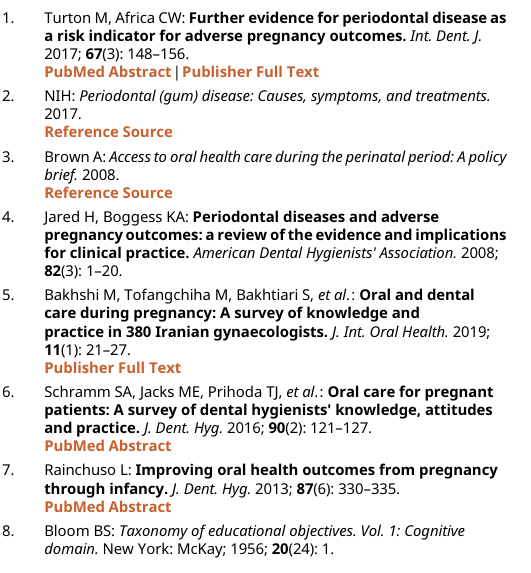
Figshare: main study 2.sav, https://doi.org/10.6084/m9.figshare.17197283.v2. 16